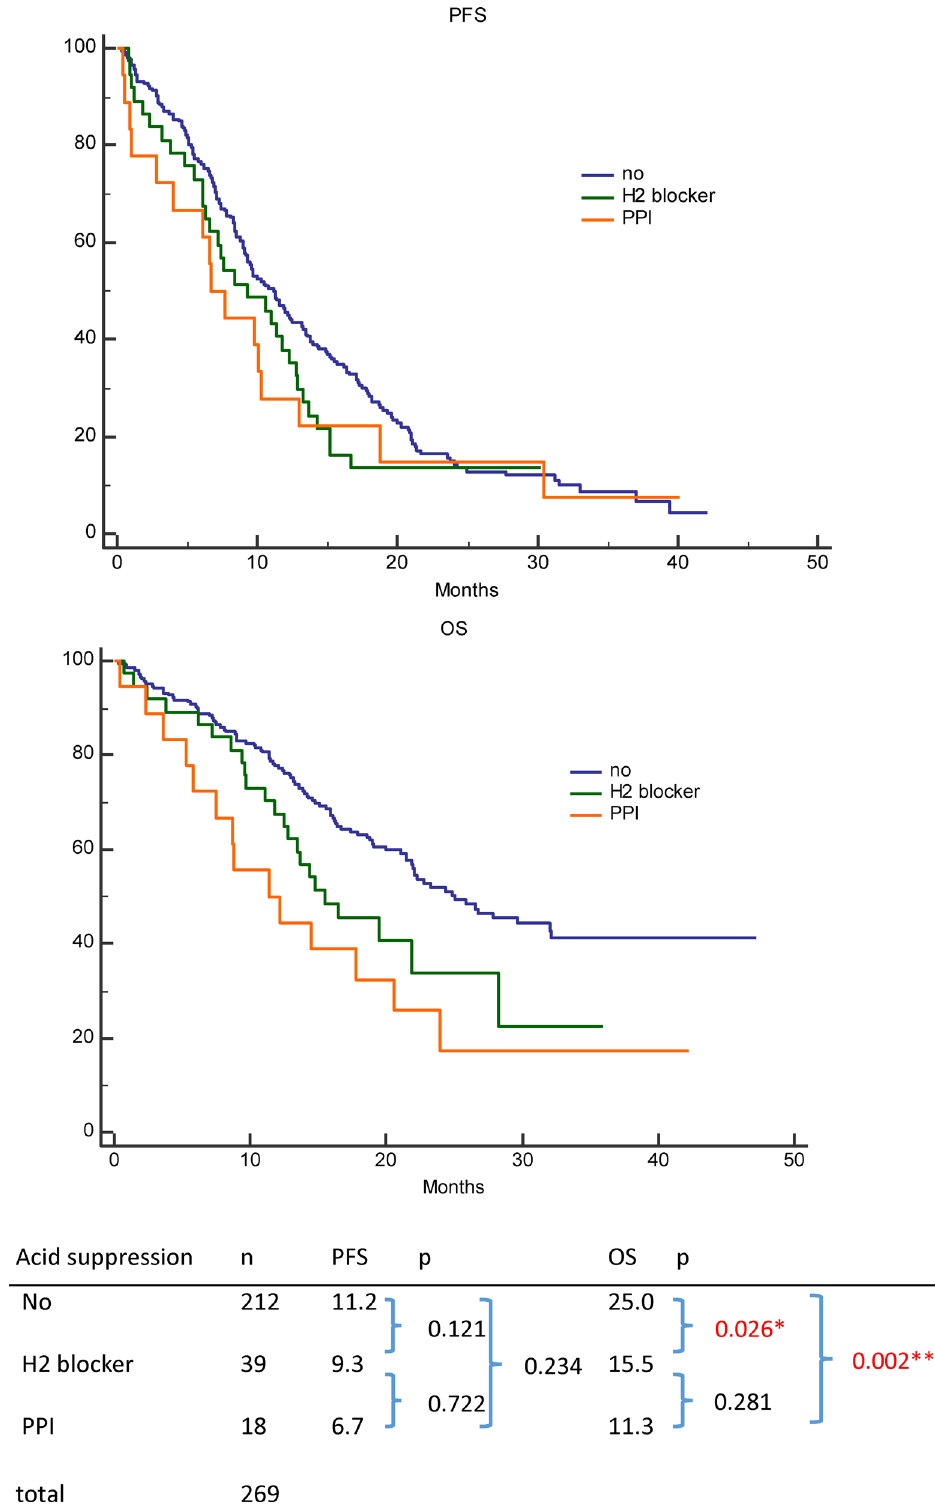
Fig 2. Progression-free survival (PFS) and overall survival (OS) according to antacid use among patients with epidermal growth factor receptor-mutant non-small-cell lung cancer who were treated using first-line tyrosine kinase inhibitors. (top) PFS among patients who were receiving proton pump